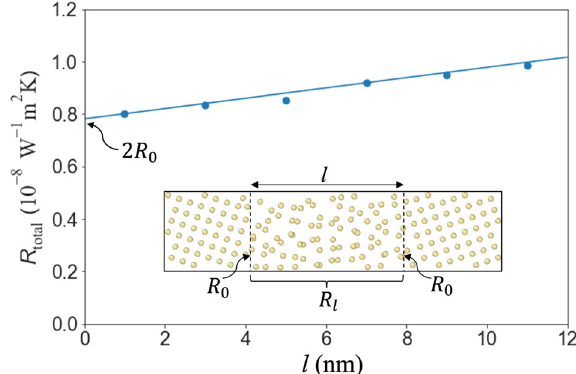
Fig. 2 Length dependence of total thermal resistance ( R total ) of a disorderly structure. Fourier's law gives: R total = 2 R 0 + R l = 2 R 0 + r × l , where R 0 is the crystalline – amorphous resistance, and R l and r is the resistance and resistivity of the amorphous (device) region,